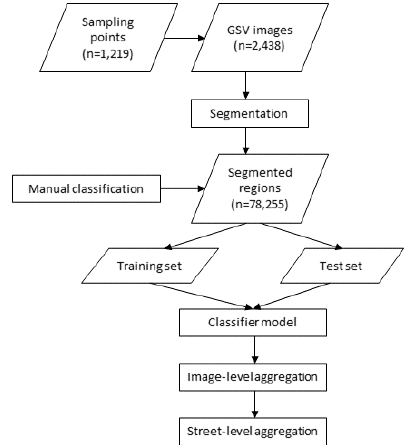
Figure 1. Street-level sidewalk classification